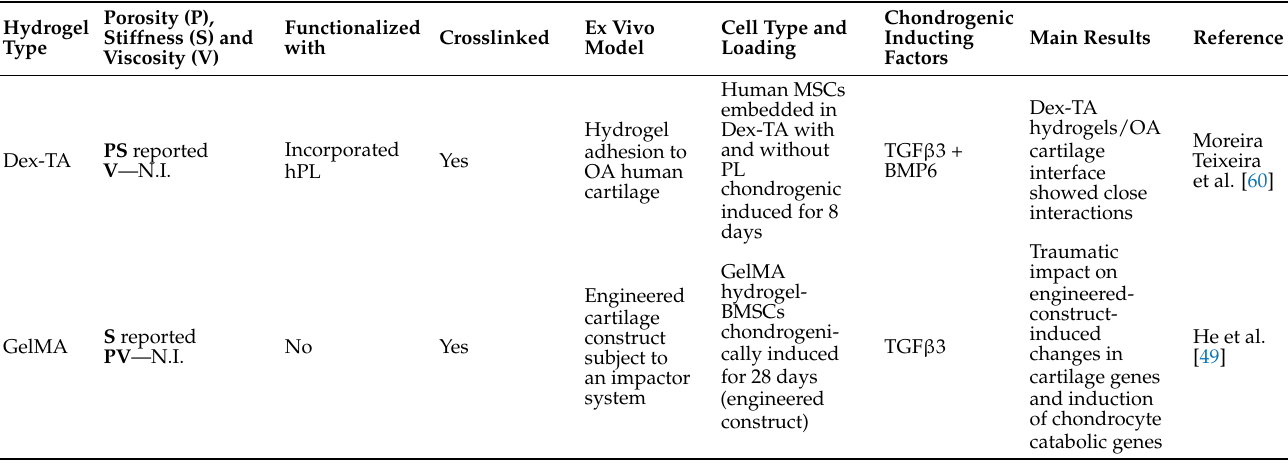
Table 2. Summary of the main results of selected ex vivo